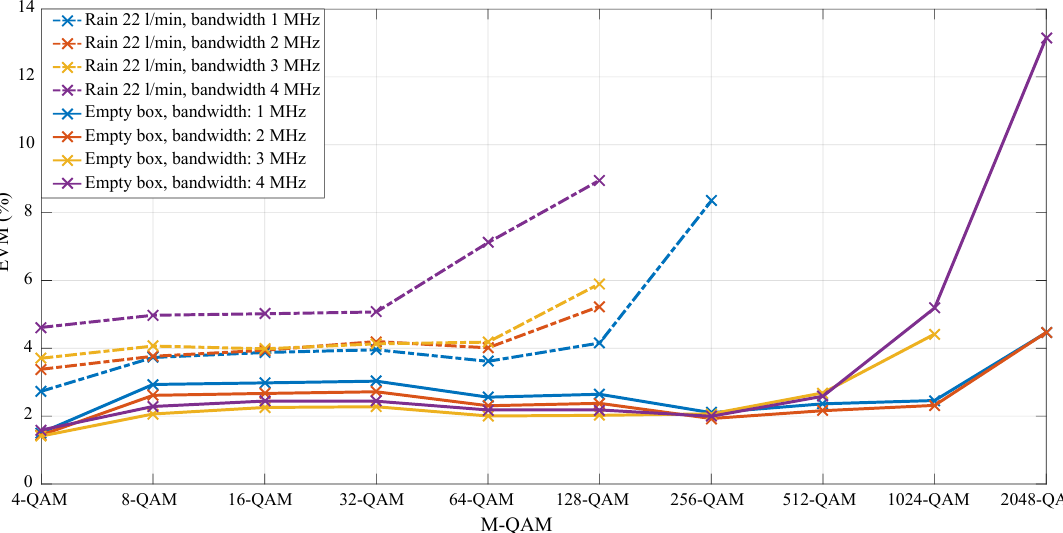
Figure 31. EVM/distance relationship for Octavia tail-light with different M-QAM and bandwidths —scenario 4—Rain 22